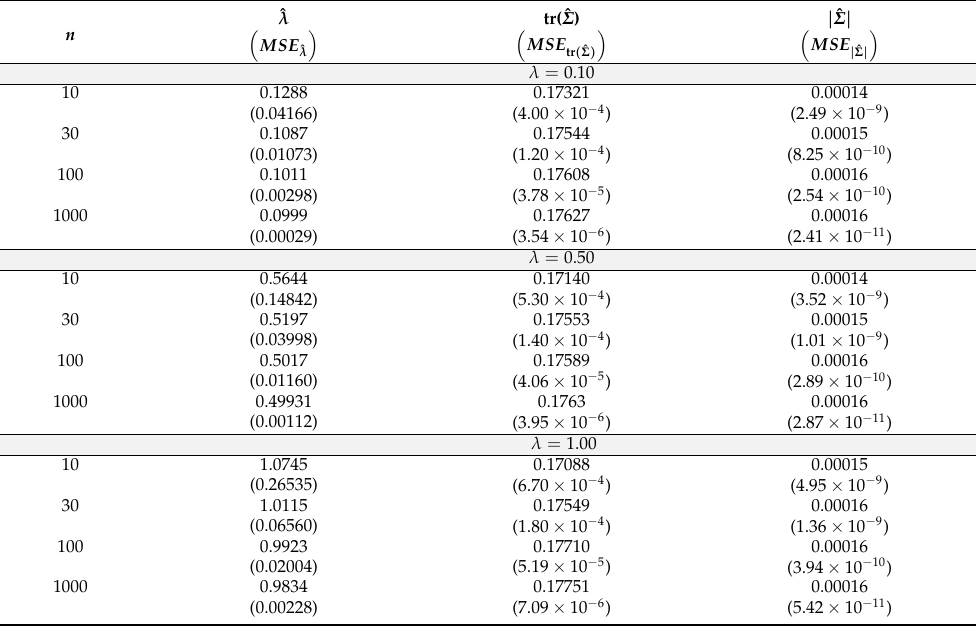
Table 2. Performance of MLEs for CTP W C m data.